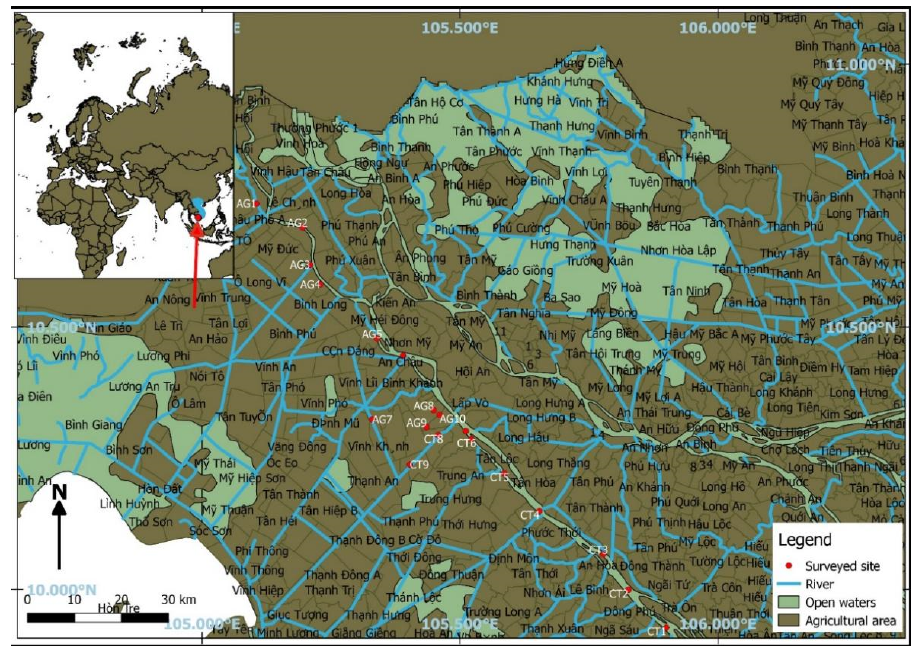
Figure 1. Location of the sampling sites in An Giang and Can Tho Provinces. Table 1. Description of the sampling sites.